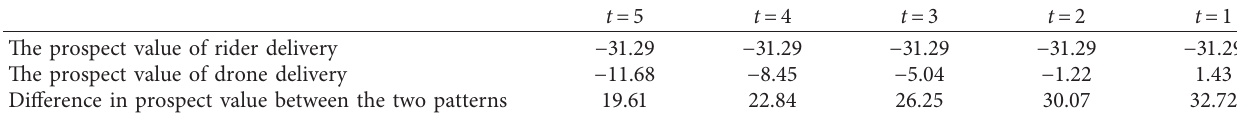
Table 8: The comparison of the prospect value of the two delivery patterns under different one-way pickup times when c � 1.3, δ � 1, and L � 5.